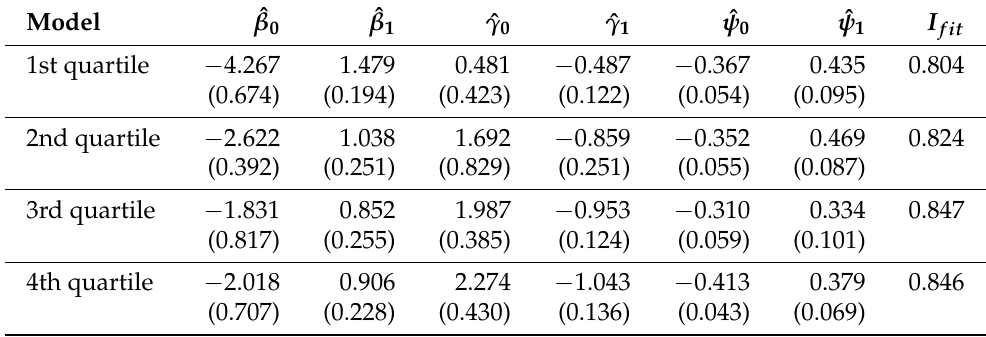
Table 2. Estimation results (standard errors in parentheses) by income